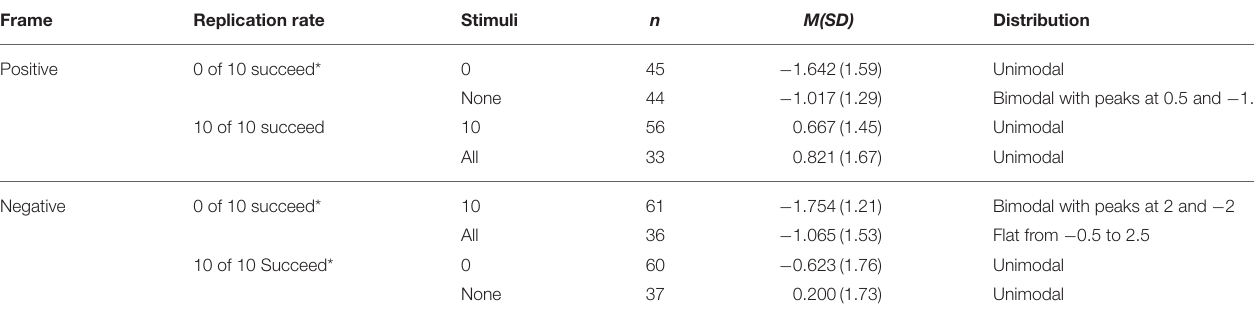
TABLE 5 | Descriptive statistics for the 0 of 10 and 10 of 10 replication rate conditions of Experiment 3.